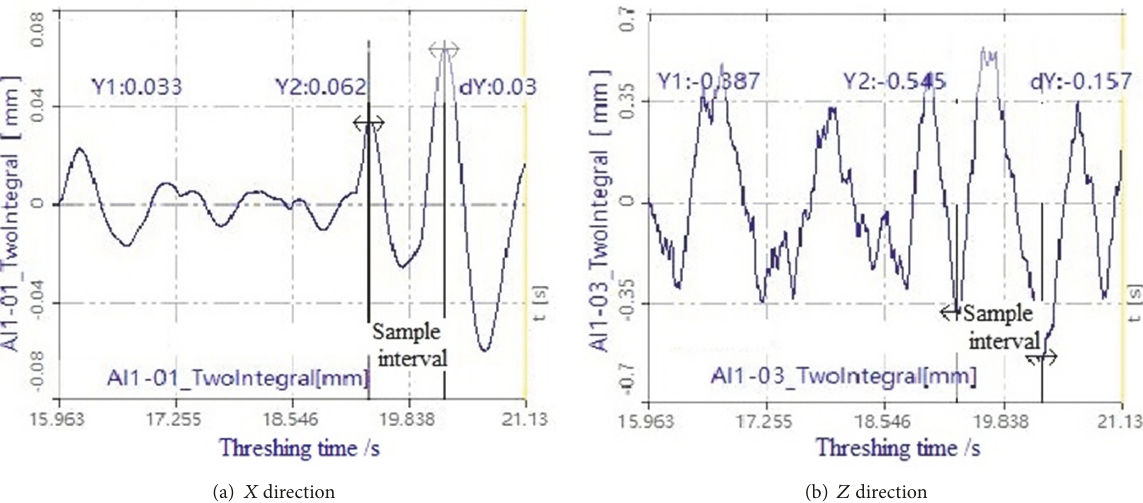
Figure 15: Typical vibration waveform of rice threshing